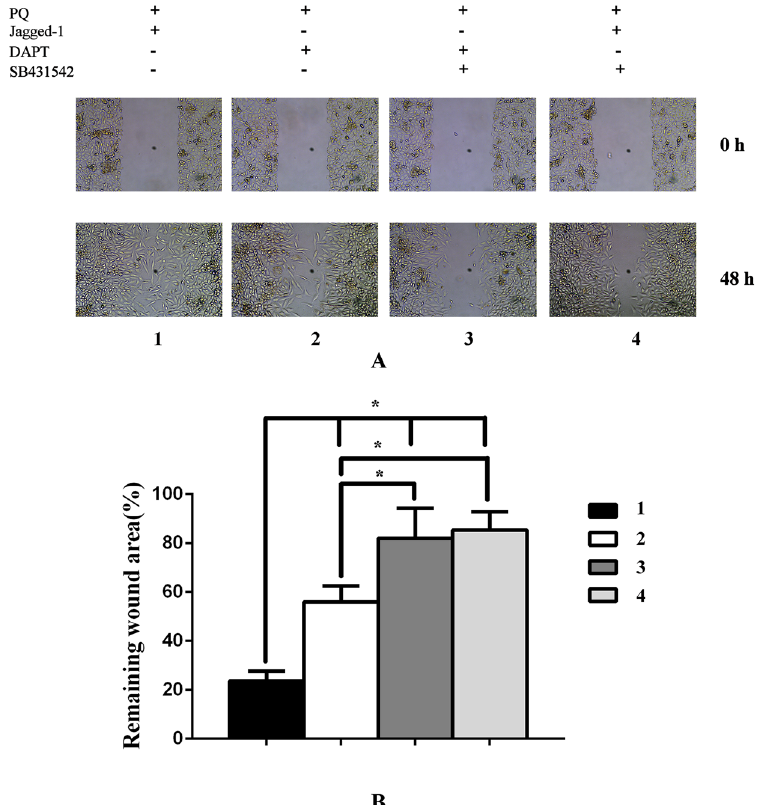
Figure 3. Monolayer wound-healing results of different treatments to A549 cells. A significantly increased migration capacity was observed after Jagged-1 (a Notch1 protein ligand, 500 ng/mL) stimulation, while a decreased capacity upon treated with DAPT (a γ -secretase inhibitor,10 μ mol/L). And the migration property of A549 cells decreased apparently after treated with SB431542 (a specific inhibitor of TGF- β receptor type I/ALK5 kinase that phosphorylates Smad2/3, 10 μ